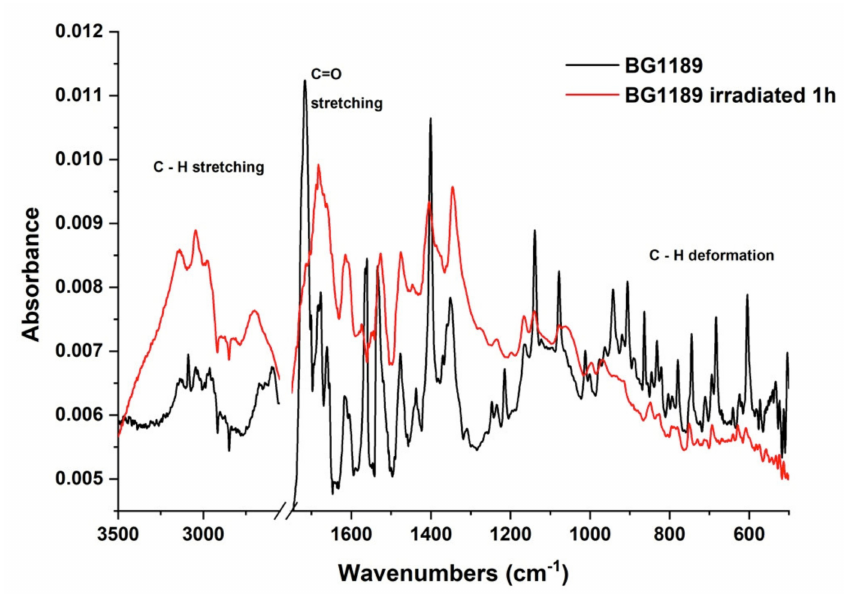
Figure 7. FTIR spectra of the unirradiated and 1 h irradiated BG1189 10 − 3 M solutions in